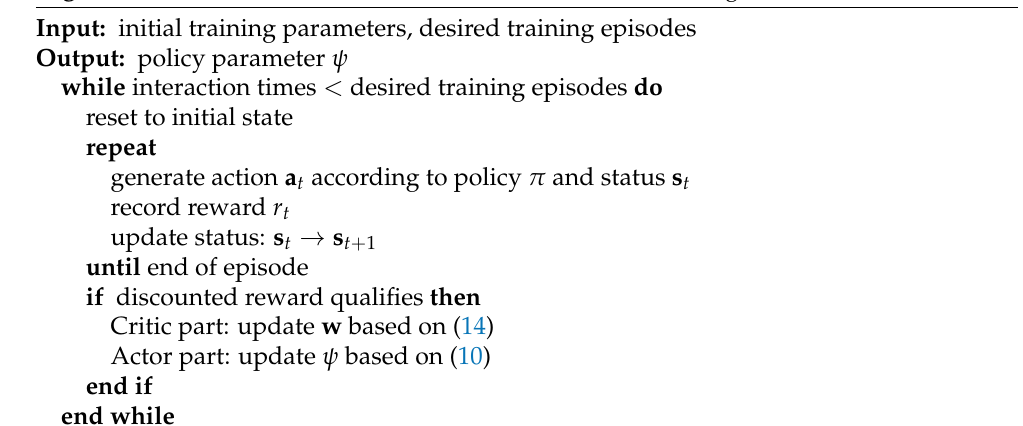
Algorithm 1 Robot Admittance Control based on the eNAC Algorithm.